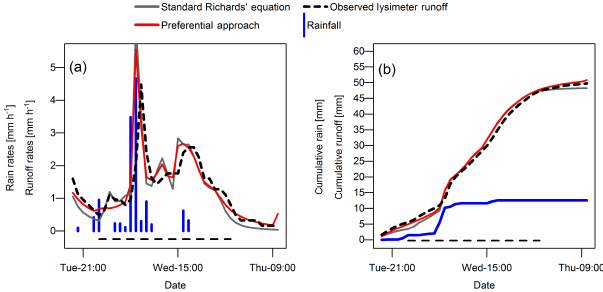
Figure 2. (a) Example of a ROS event occurring at WFJ. The entire extent of the x axis refers to the evaluation period; the bar above the x axis refers to the event length. (b) Cumulative version of the